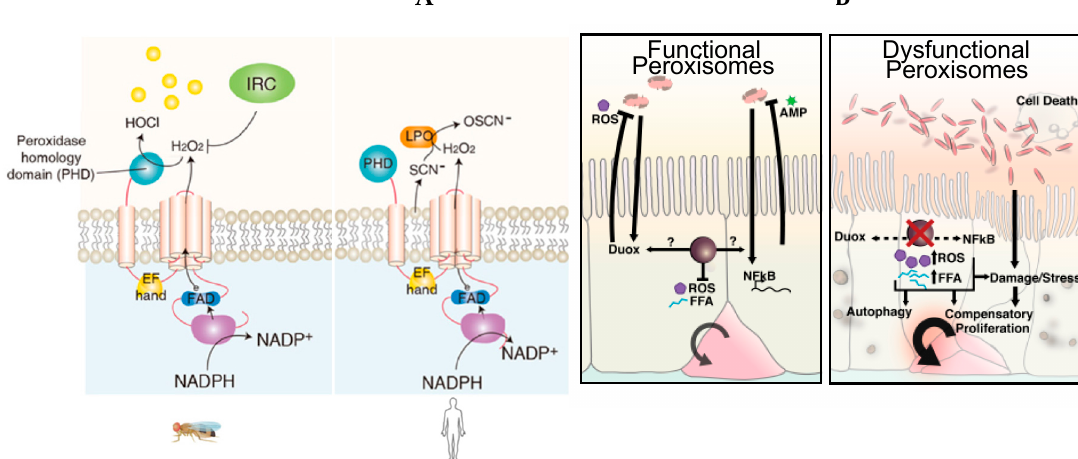
Figure 4. The dual oxidase (DUOX) pathway and reactive oxygen species (ROS) regulation. ( A ) Diagram of the conserved DUOX protein domains in Drosophila melanogaster and humans. In Drosophila , the peroxidase homology domain of DUOX converts H 2 O 2 into HOCl in the presence of chloride. DUOX-dependent H 2 O 2 molecules are eliminated by immune-regulated catalase (IRC) activity. In humans, DUOX-dependent H 2 O 2 is used for the oxidative conversion of SCN − to OSCN − by the enzymatic action of lactoperoxidase in the mucosal fluids (extracted and modified from Figure 1A of [139]). ( B ) In Drosophila enterocytes, peroxisomes integrate and modulate the stress and immune pathways to maintain enteric homeostasis, mount host defense in the gut, and promote gut renewal. These processes are impaired in the presence of dysfunctional peroxisomes and lead to an intracellular accumulation of ROS and free fatty acids (FAAs), and cell death [149].